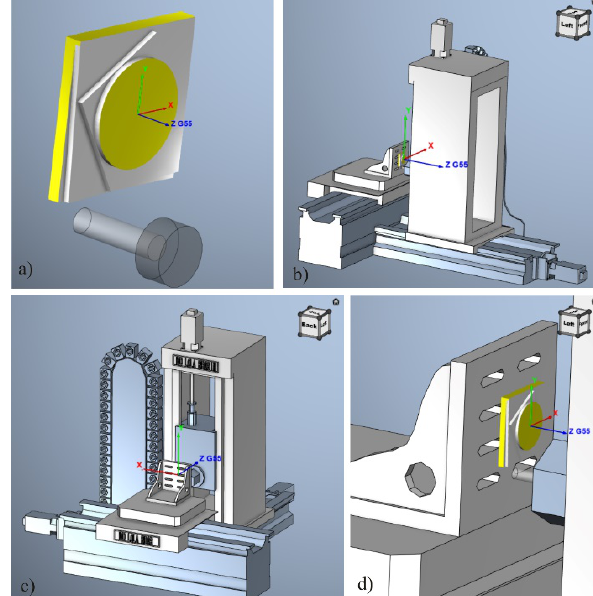
Figure 9.Simulation of virtual machine operation in Vericut